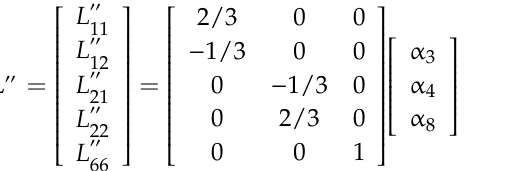
Table 6. Calibrated parameters for the plastic potential function of the niobium sheet for every 10 MPa increments of the plastic work ( m =